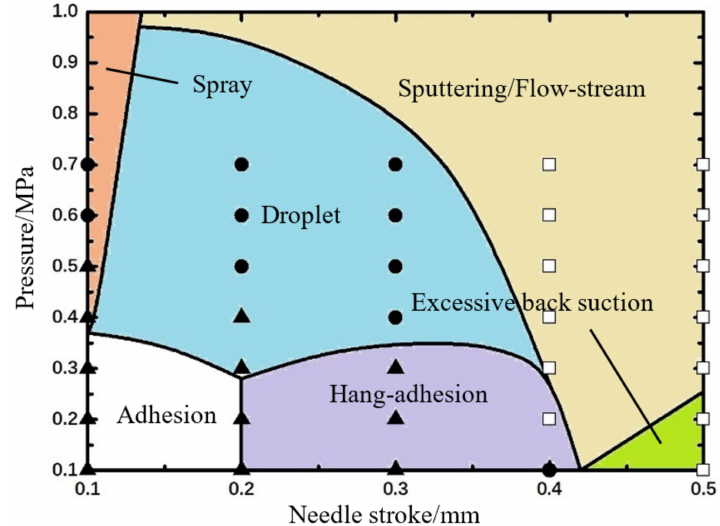
Figure 9. The combined effects of pressure and needle stroke on droplet formation and separation process based on numerical simulations. The symbols represent experimental results: “ ” indicates droplet, “ (cid:78) ” indicates adhesion, “ (cid:3) ” indicates flow-stream. The experimental parameters are set as: viscosity: 800 mPa · s, nozzle diameter: 0.2 mm, length: 2 mm, needle cycle: 20